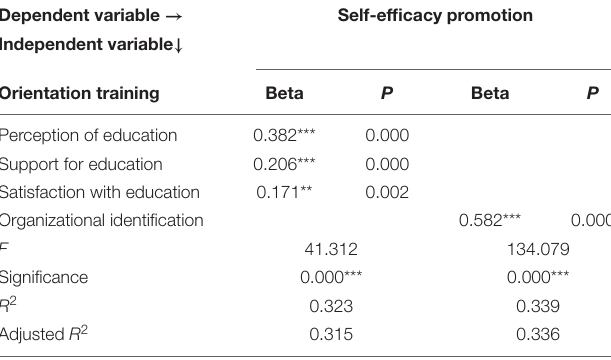
TABLE 2 | Analysis of orientation training, organizational identification, and self-efficacy